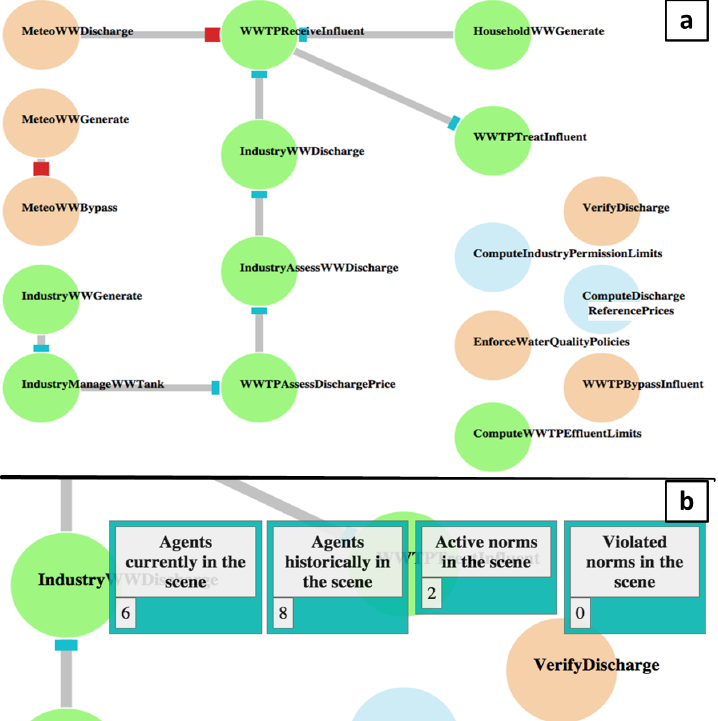
Figure 7. ( a ) Agents are traversing the different scenes during the simulation as they perform actions; ( b ) detailed information about the number of participating agents and which have played in a particular scene, i.e., IndustryWWDischarge